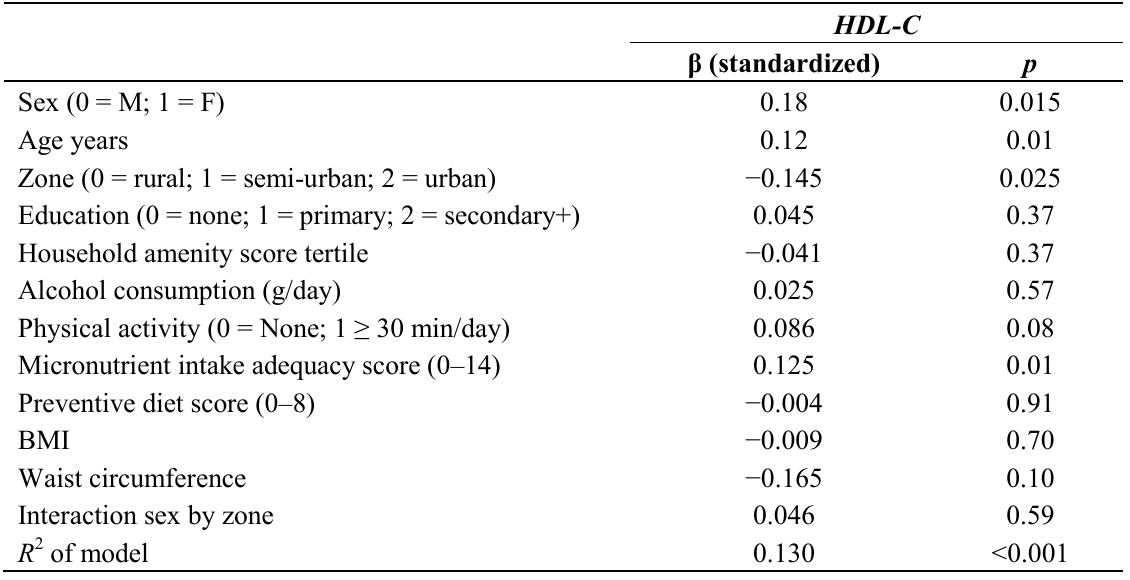
Table 5. Linear regression of HDL-C on dietary and lifestyle factors controlling for